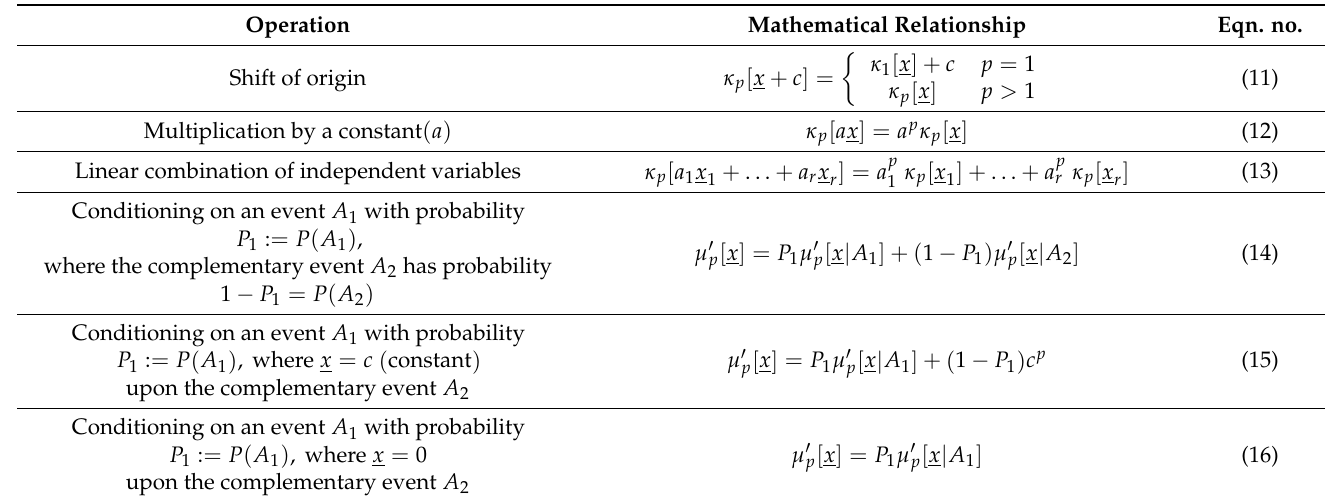
Table 1. Typical operations useful in simulation and their mathematical handling.